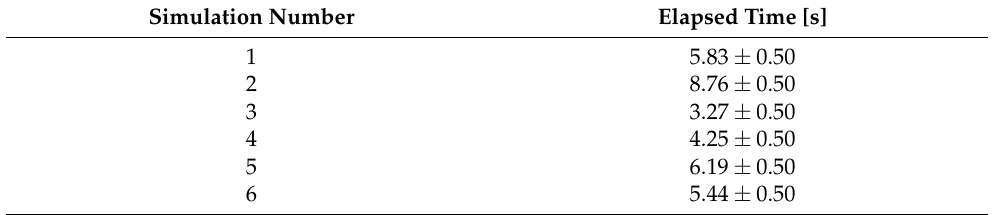
Table 2. Simulations’ process